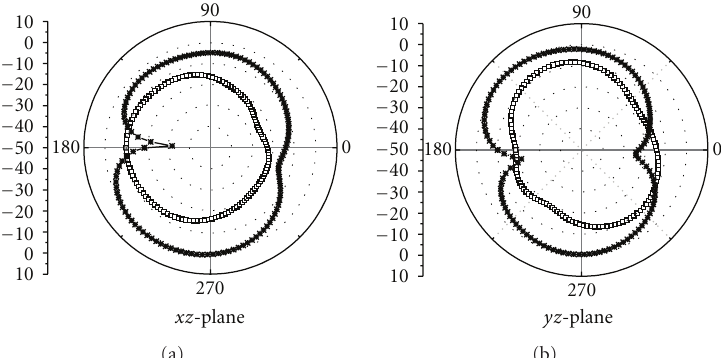
Figure 10: Measured radiation pattern of the proposed antenna at the frequencies of 890MHz and 1940MHz (line with rectangle: E -phi; line with cross: E -theta).